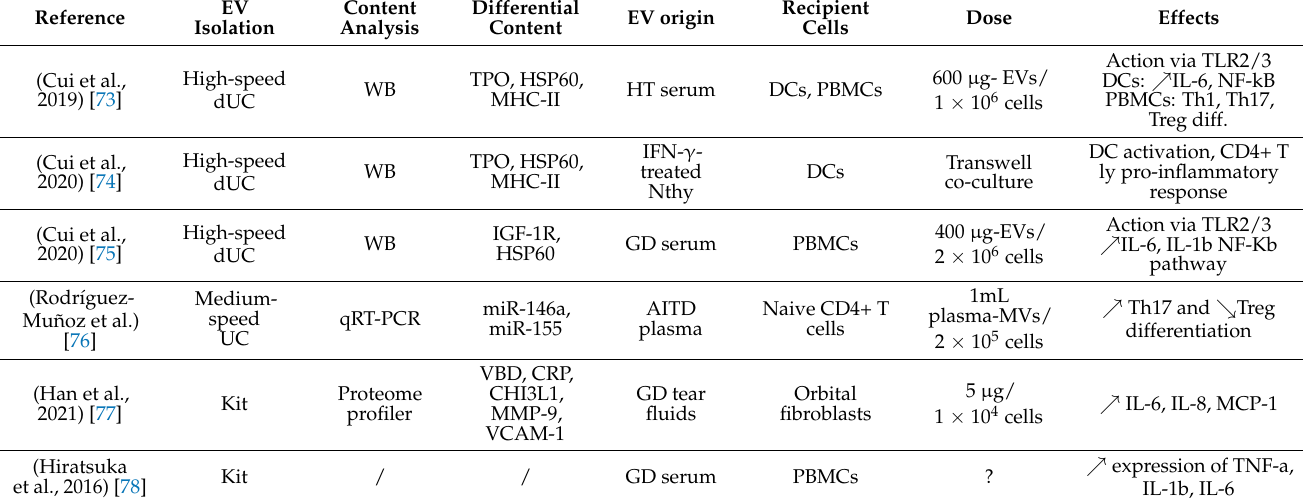
Table 3. List of publications analyzing the function of EVs in AITDs. HT—Hashimoto’s